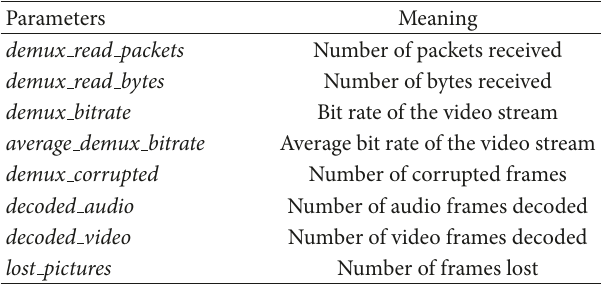
Table 1: Receiving parameters in VLC input.item (): stats